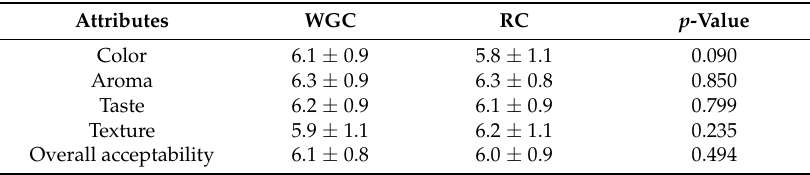
Table 5. Sensory evaluation of infant cereals by parents (mean ±